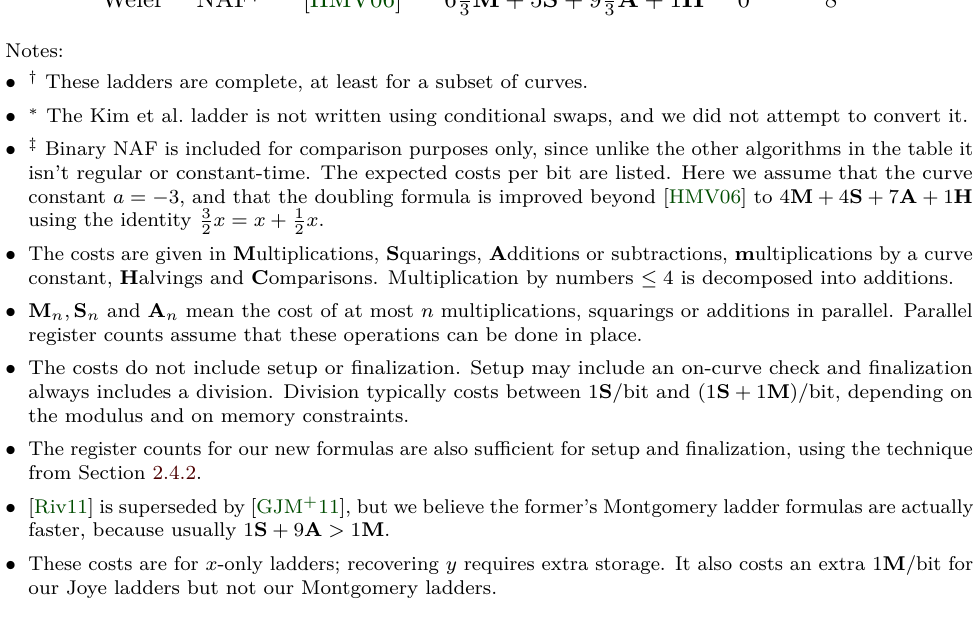
Figure 2: Comparison to selected previous